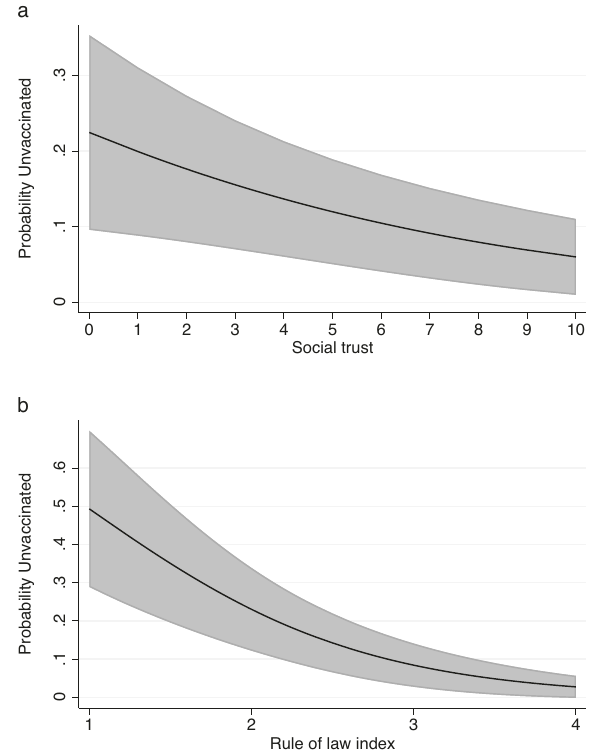
Fig. 2 Social Trust, Attachments to the Rule of Law, and Vaccination Status. Predicted probabilities of being unvaccinated by social trust ( a ) and attachments to the rule of law ( b ), holding all other factors constant at their medians. Shaded bands indicate 95% con fi dence intervals.